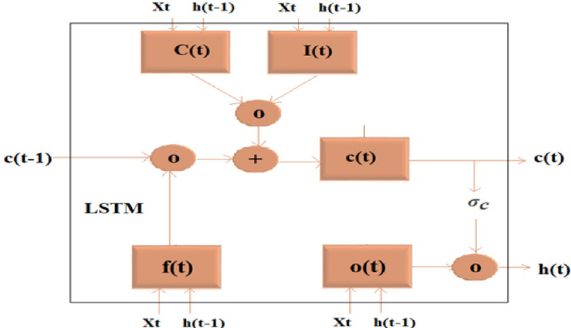
Figure 8. LSTM Architecture 60 .